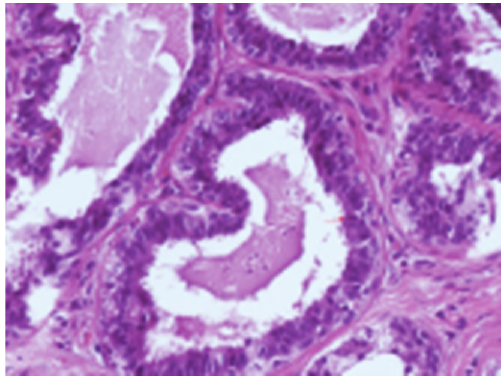
Figure 2: H.E.—flat epithelial atypia (DIN1a)—large TDLU with one to three layers of atypical ductal cells and